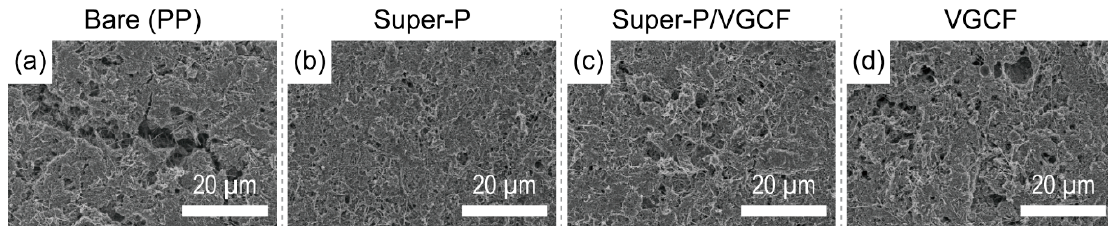
Figure 4. SEM images of the surfaces of ( a )–( d ) sulfur cathodes after 20 cycles (corresponding to Figure 3c).